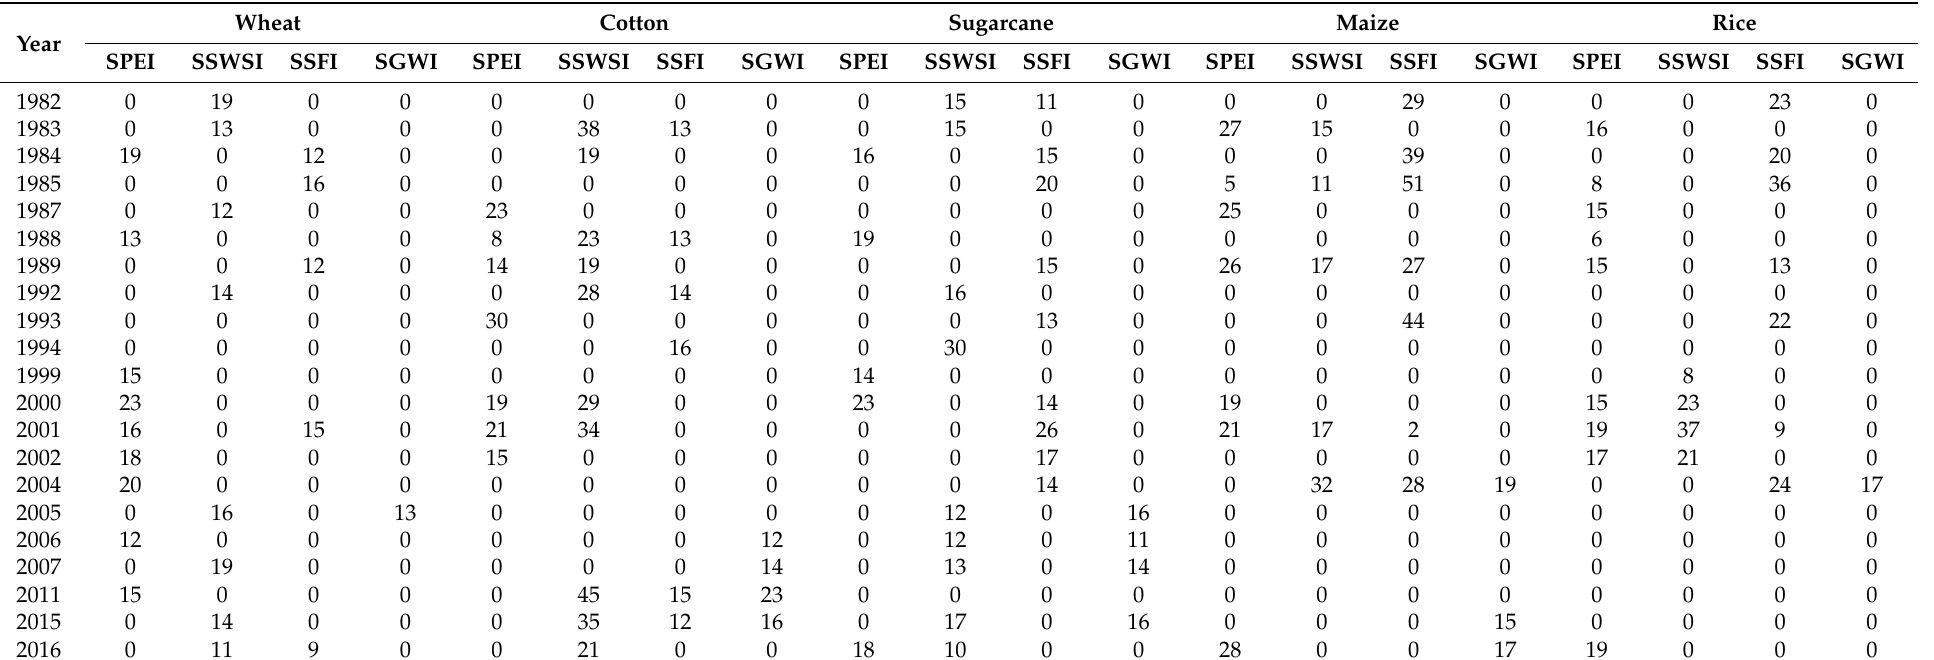
Table 3. Quantification of crop yield losses (%) during intense drought episodes from 1981 to